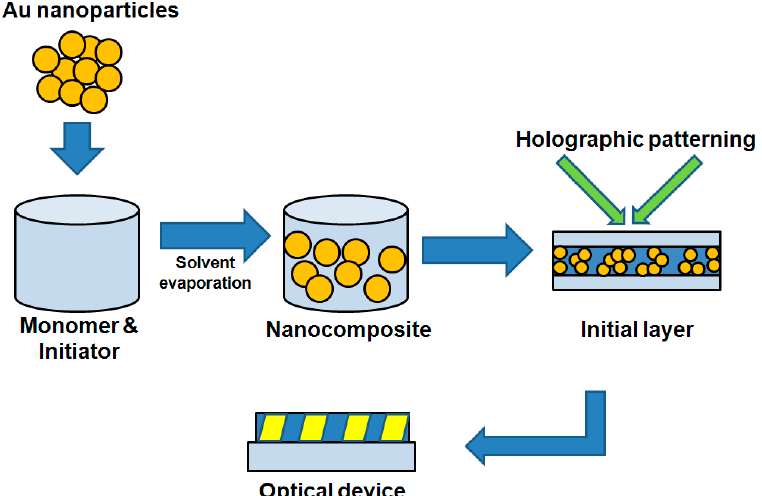
Figure 10. Schematic of the nanocomposite preparation and optical active element